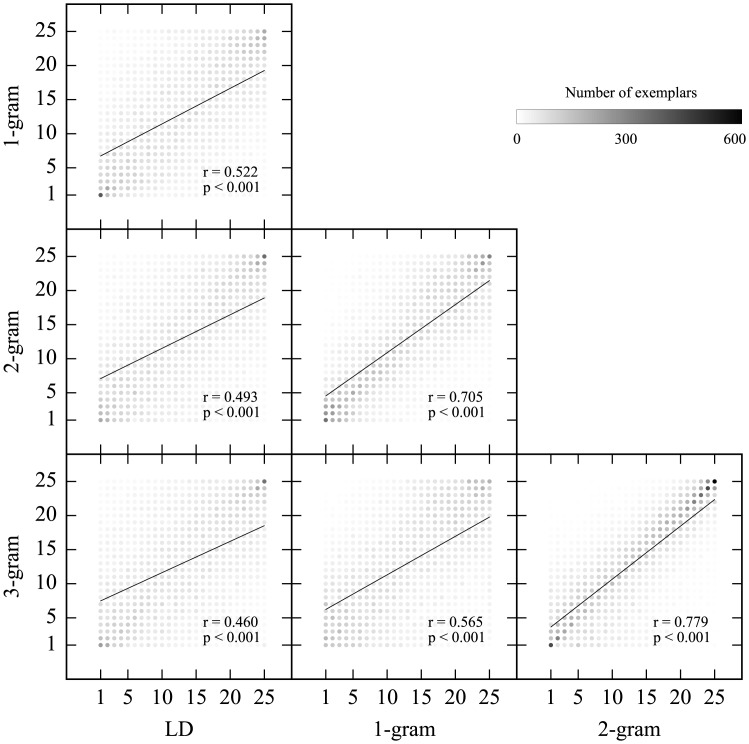
Spearman’s rank correlation coefficients among ranks in the four measures of dissimilarities.Gray scales indicate numbers of exemplars for each dot. The x and y axes are ranks of each dissimilarity.